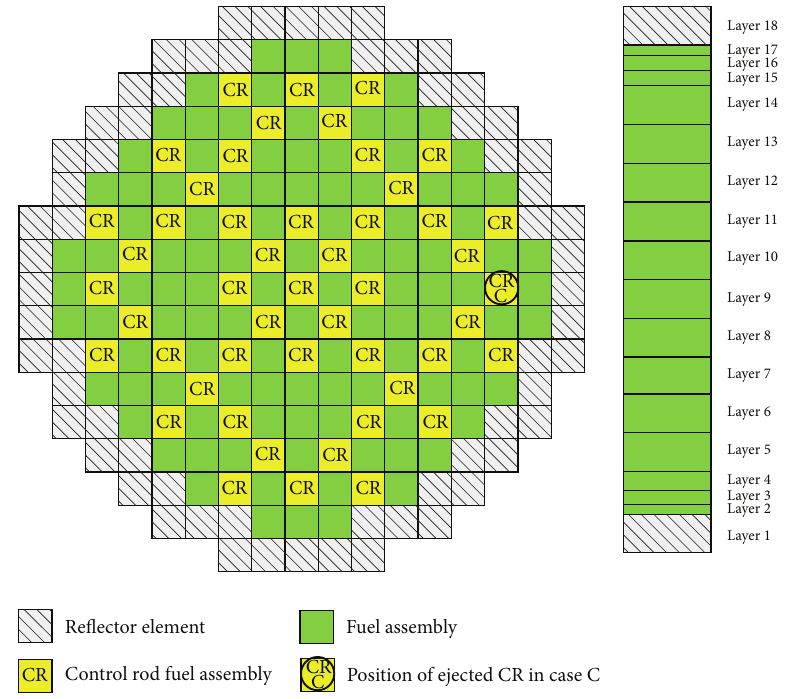
Figure 2: PWR NEACRP core model of case C